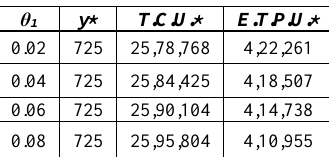
Table 3. Impact of θ 1 on optimal production policy